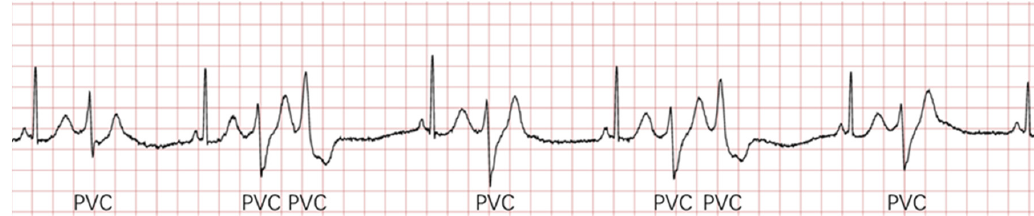
Figure 2. There are some PVC waveforms from the same person. The waveforms of these PVCs in the picture are different, especially the second and third.